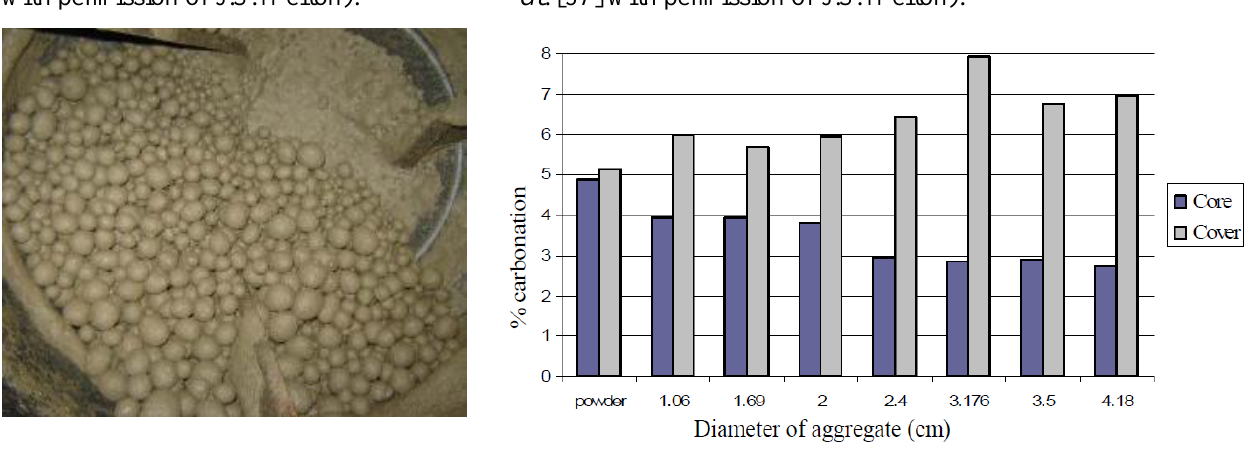
Figure 13. Artificial aggregate in mini Figure 14. Percentage (%) of carbonated depth in core and concrete mixer (from Melton et al . [37] cover of the artificial aggregate from the soil (from Melton et with permission of J.S. Melton). al . [37] with permission of J.S.